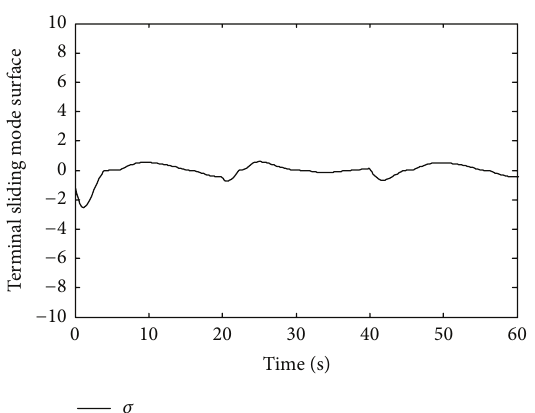
Figure 8: Terminal sliding mode surface 𝜎 .